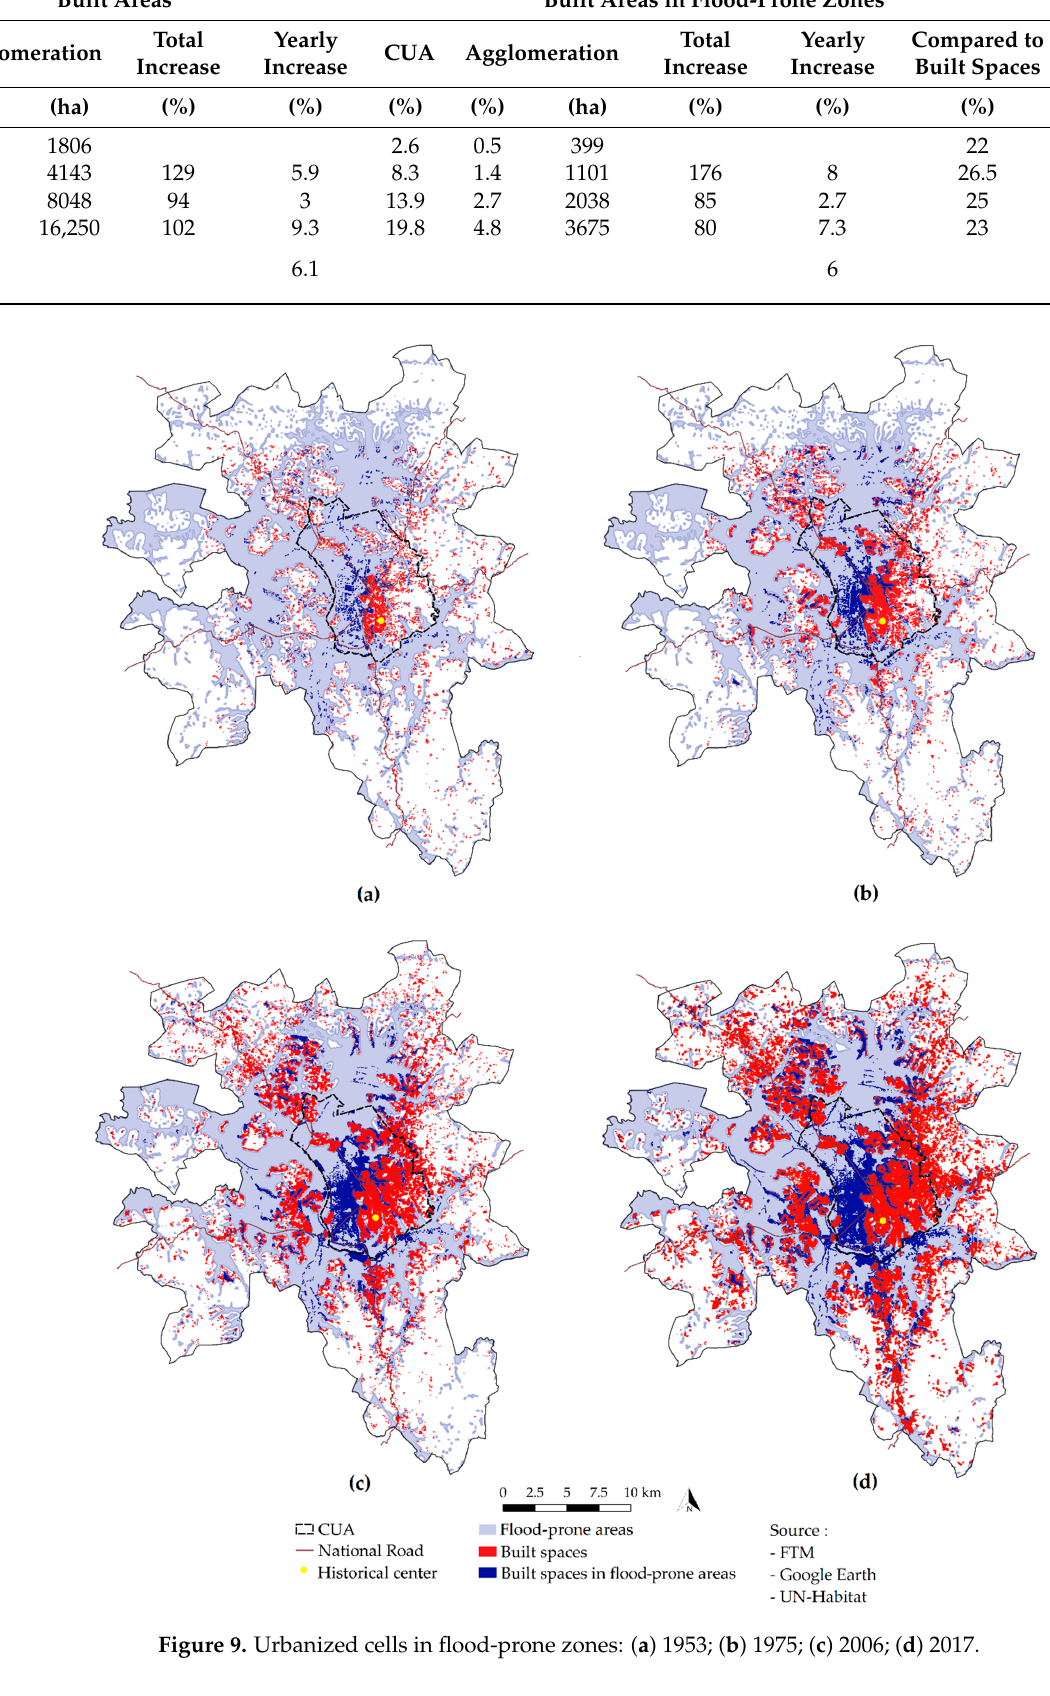
Table 2. Extent and increase of urbanized cells and built areas in flood-prone zones.